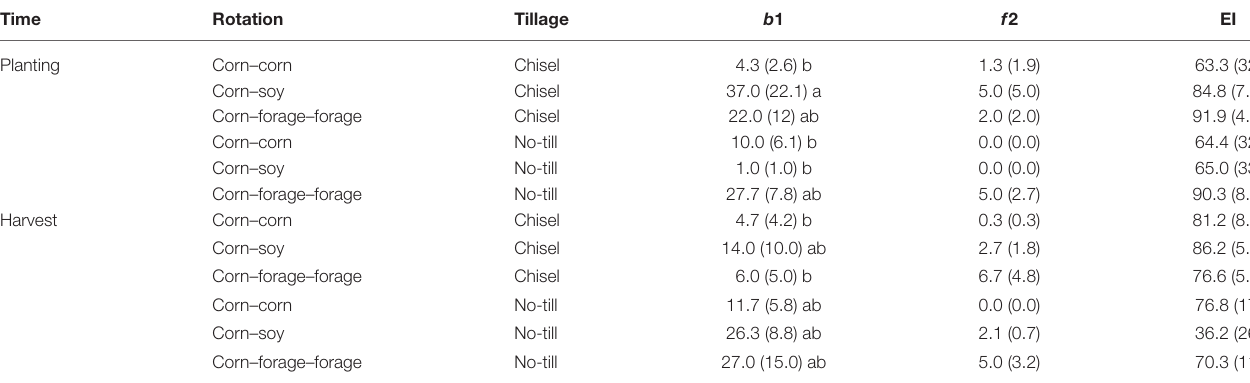
TABLE 3 | Mean and (SE) ( n = 3) of the abundance of enrichment opportunist bacterial feeders ( b 1), abundance of enrichment opportunist fungal feeders ( f 2), and the Enrichment Index (EI) from planting (May 2020) and harvest (October 2020) from a long-term trial comparing tillage and crop rotational diversity in Northwest Ohio. Time Rotation Tillage b